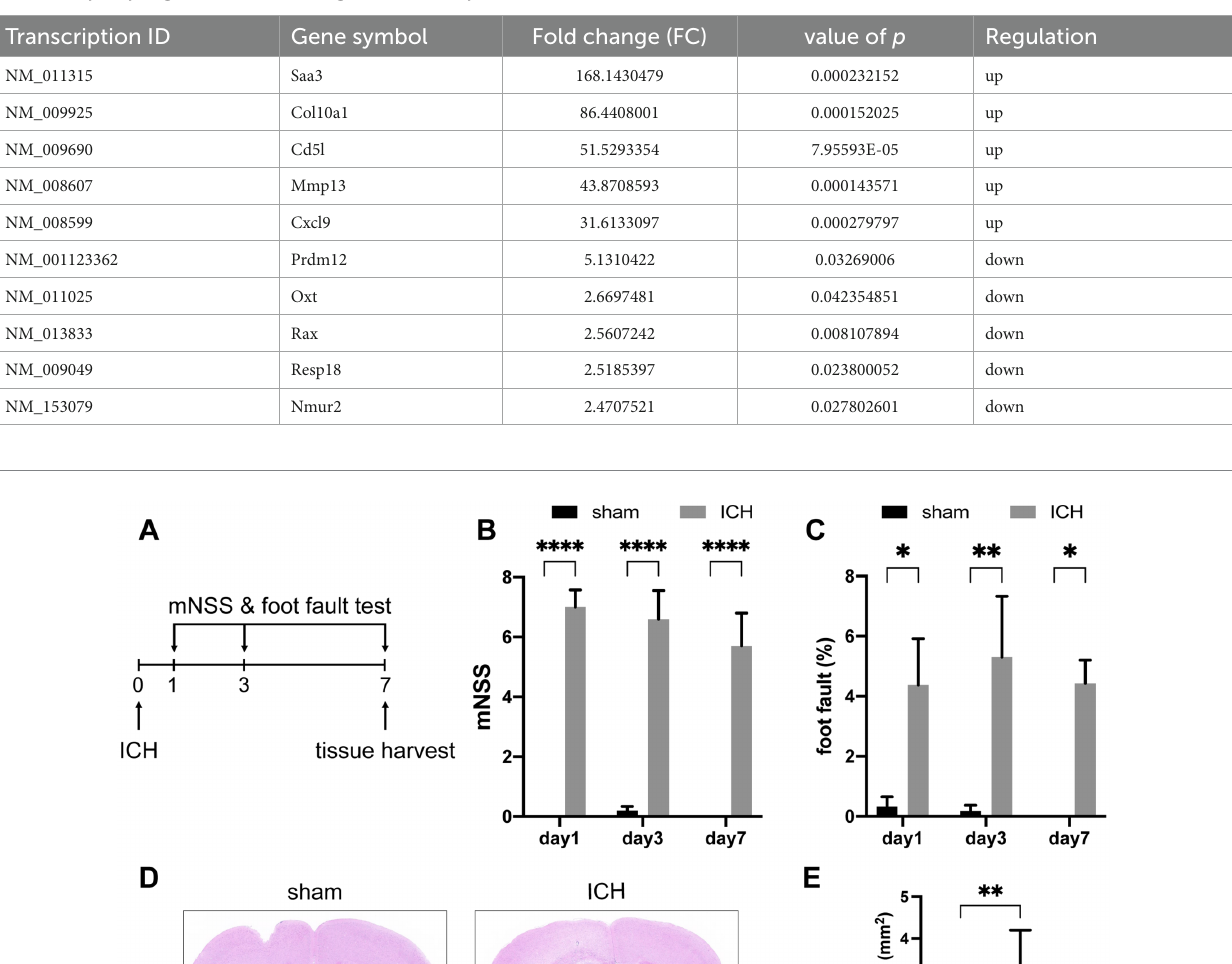
TABLE 2 Top 5 up-regulated and down-regulated mRNAs post-ICH.